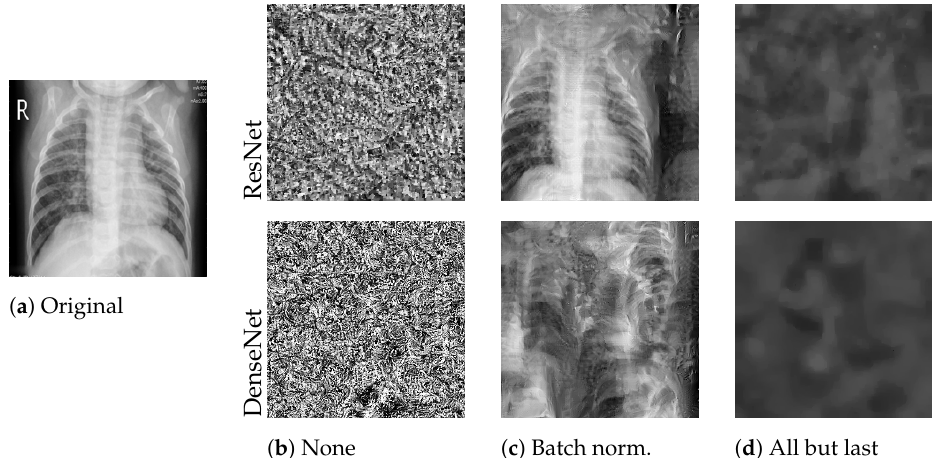
Figure 2. Best reconstructed images with varying layer freezing techniques. We attacked the locally trained model from a client holding a single Mendeley image ( a ). None ( b ) refers to full model training, Batch norm. ( c ) to freezing batch normalization layers, and All but last ( d ) to only training the output layer.